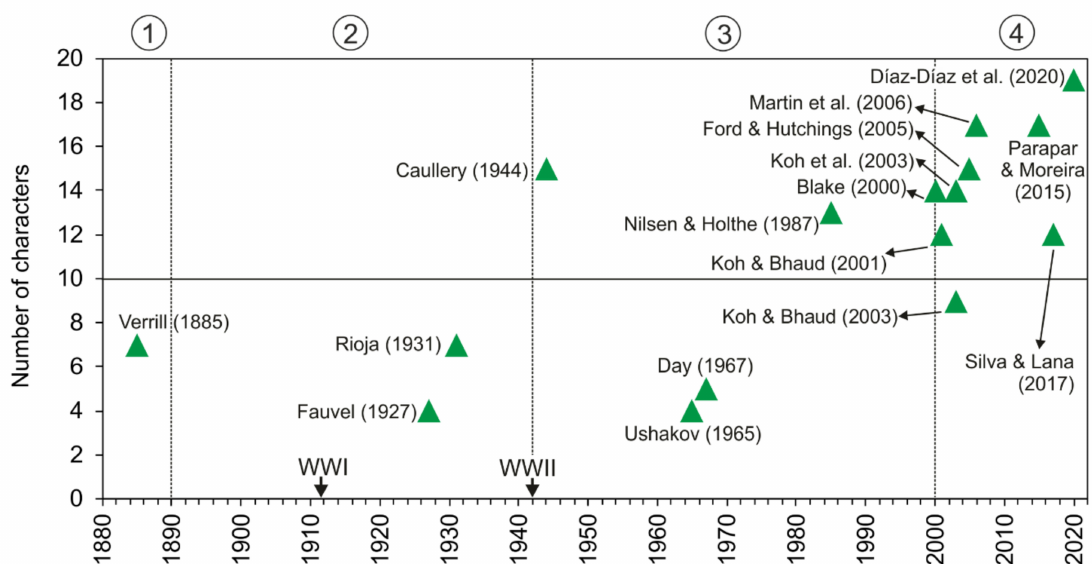
Figure 18. Number of characters (accumulated) used in the description of Owenia species. Encircled numbers denote relevant historic moments (separated by discontinuous lines): ( 1 ) from the first described species to 1890; ( 2 ) 1890 to the end of WWII in 1945; ( 3 ) 1945 to 2000; ( 4 ) 2000 to present. Species described in each paper corresponds to O. fusiformis or to the original description of the taxon. Verrill [166] ( O. artifex ); Fauvel [151] ( O. fusiformis ); Rioja [167] ( O. fusiformis );